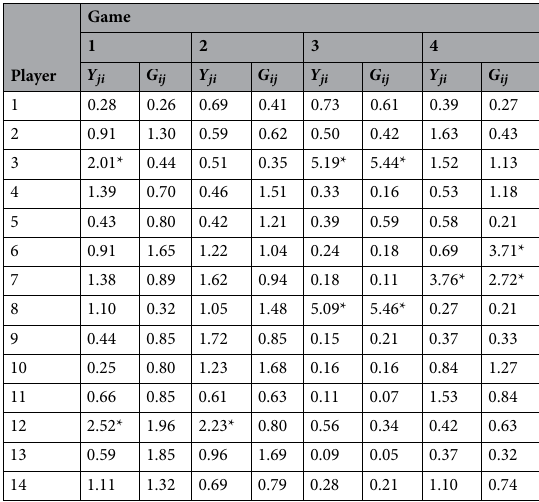
Table 4. Standardised influence metrics. Values larger than 2 are marked with a * to indicate players with more influence on the